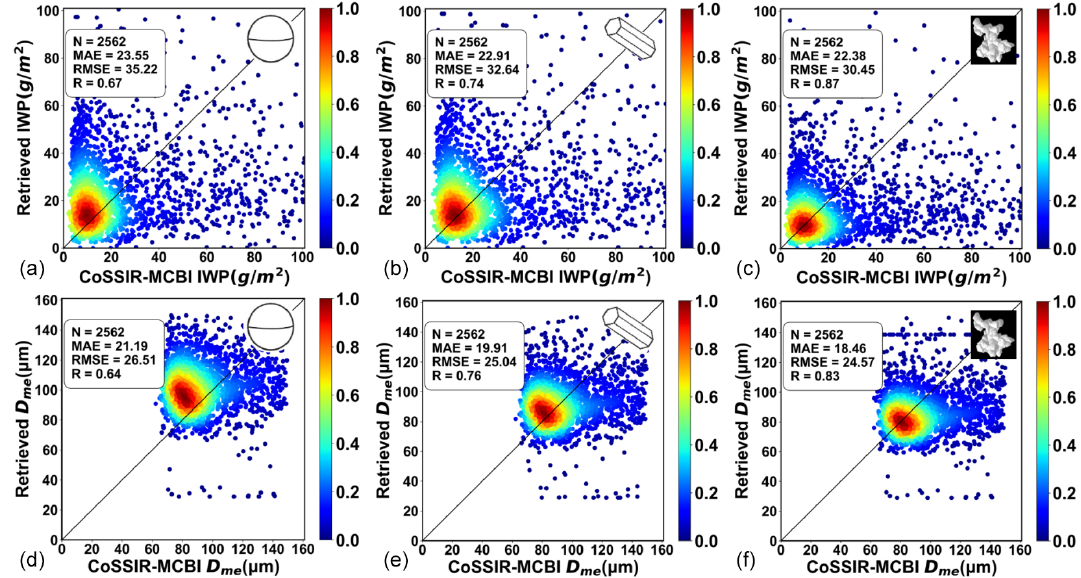
Figure 12. The scatterplots of the retrieved IWP (a–c) and D me (d–f) against the CoSSIR-MCBI results for the sphere (c, f) , column (b, e) , and Voronoi (a, d) ICS